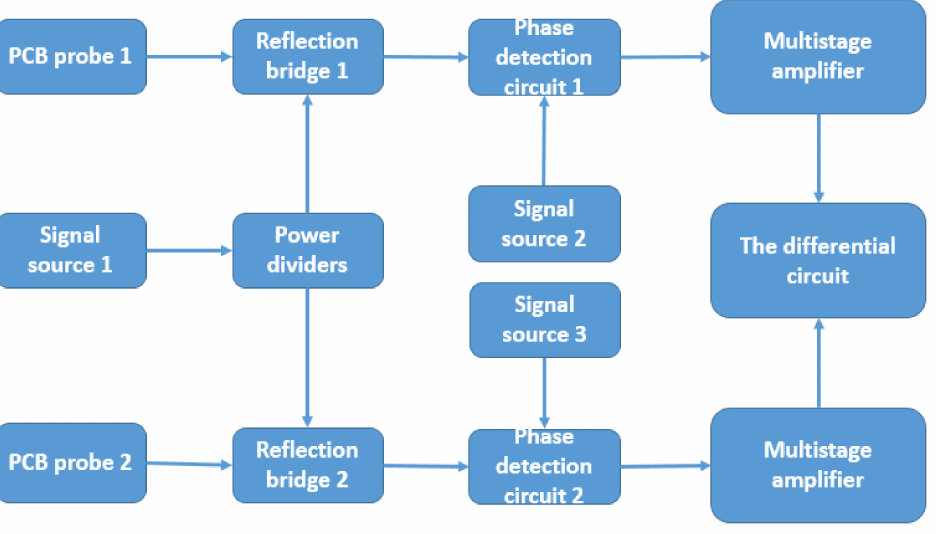
Figure 3. Flowchart of phase